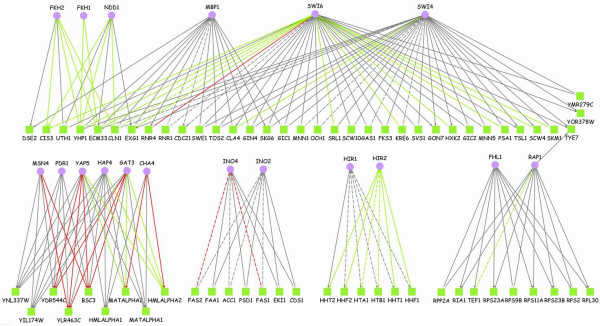
Summary of our final predictions. This network diagram is a graphical representation of our final predicted 177 TF-gene functional pairs between 18 TFs and 66 target genes (coherent linker genes). Dashed links show 24 literature-verified pairs. Links with white arrow heads represent 85 pairs with conserved motifs. Green and red links show additional information about expression correlation between TF-encoding genes and their target genes: high positive (Pearson coefficients > 0.661) and negative correlation (Pearson coefficients < -0.628) respectively. For example, the predicted functional pair of Rap1 and TEF1 (on the bottom right) is confirmed with respect to literature and conserved motifs. In addition, the pair shows high expression correlation between them. We use this additional information for detailed case studies by considering those pairs as high confident among all our predictions (see subsection 4 in Results). See Additional File 2 for better visibility of this figure and Additional File 3 for a list of TF-gene pairs together with Pearson coefficients. Generated by Cytoscape [36] and yED graph editor [37].